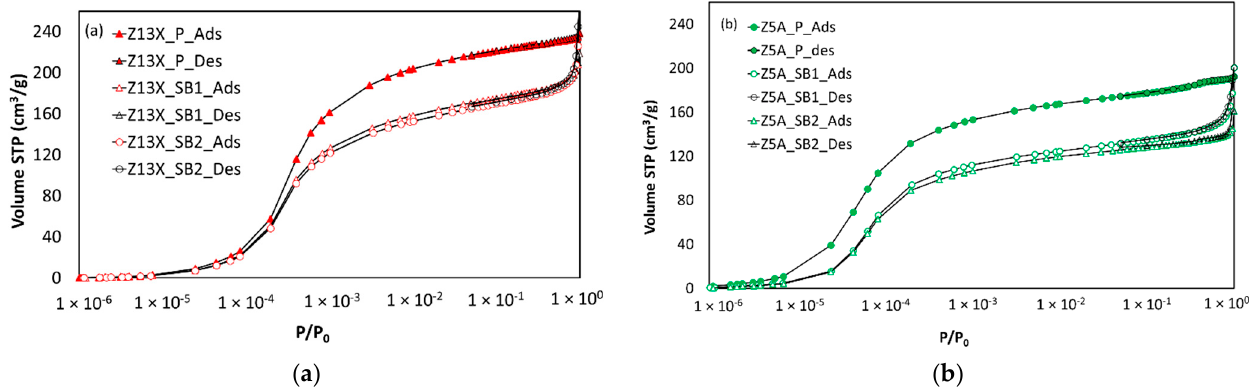
Figure 1. Argon adsorption–desorption isotherms at 87 K on different zeolites samples. ( a ) 13X zeolite, and ( b ) 5A zeolite.